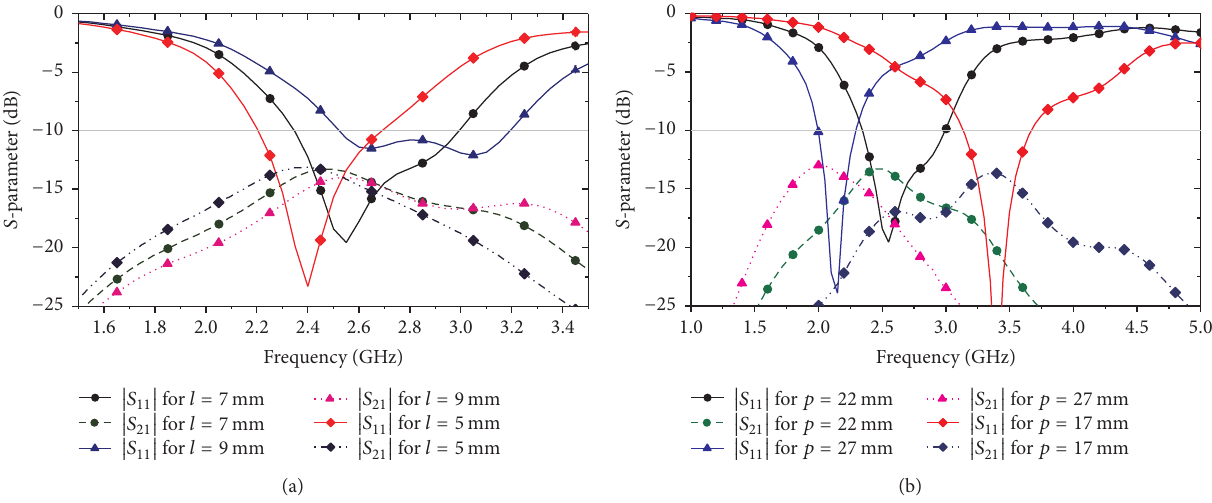
Figure 4: 𝑆 -parameters of Ant. 1 design for different notch dimensions: (a) 𝑙 = 5 mm, 𝑙 = 7 mm ∗ , and 𝑙 = 9 mm and (b) 𝑝 = 17 mm, 𝑝 = 22 mm ∗ , and 𝑝 = 27 mm ( ∗ it is of the proposed